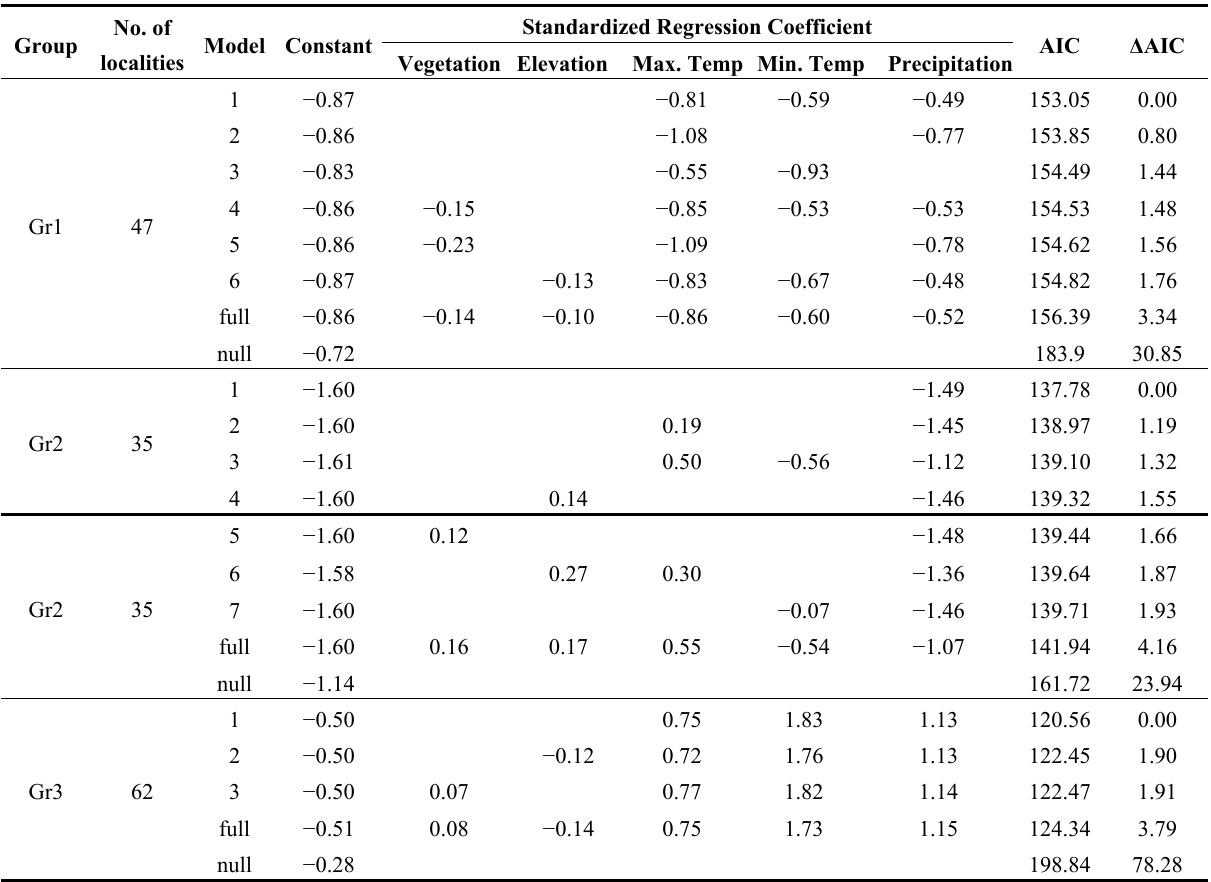
Table 4. GLM fit to the environmental variables of the three assembly groups of Protura.